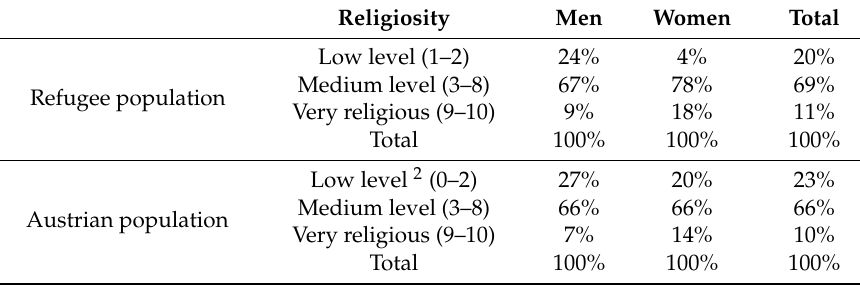
Table 1. Religiosity among surveyed refugee population and Austrian population, by sex 1 . Religiosity